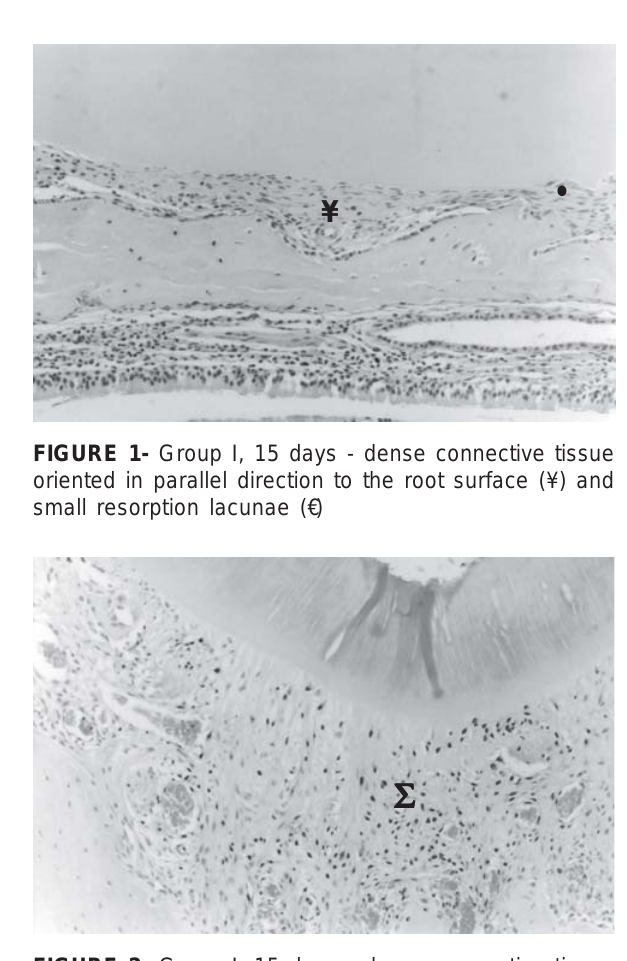
FIGURE 2- Group I, 15 days - dense connective tissue oriented in perpendicular direction to the root surface ( Σ ) TABLE 1- Histological events in the periodontal space at each study period in groups I and II